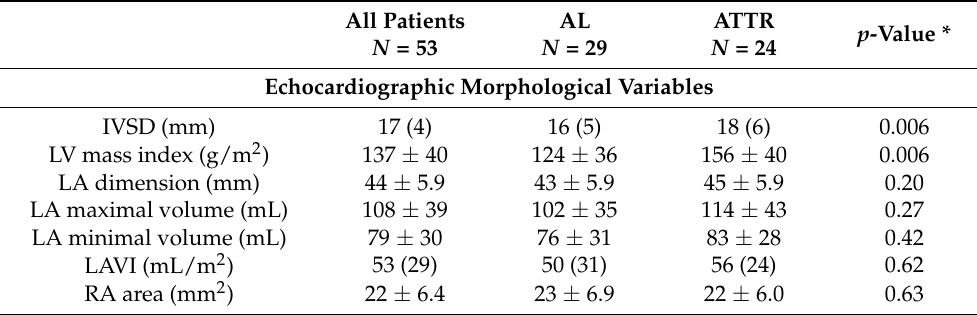
Table 2. A comparison of the echocardiographic morphological variables between the immunoglobu- lin light chain and transthyretin cardiac amyloidosis patients. All Patients